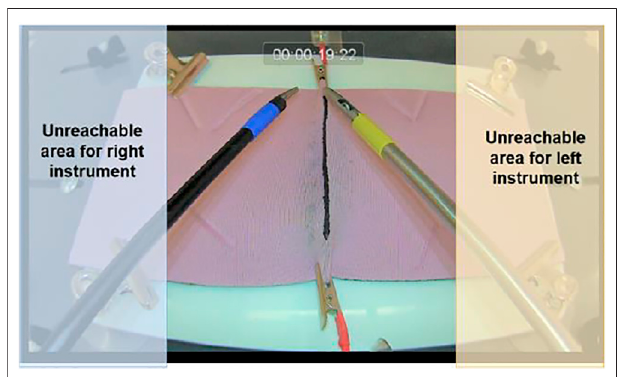
FIGURE 2 | Practical workspace for both instruments based on the collected